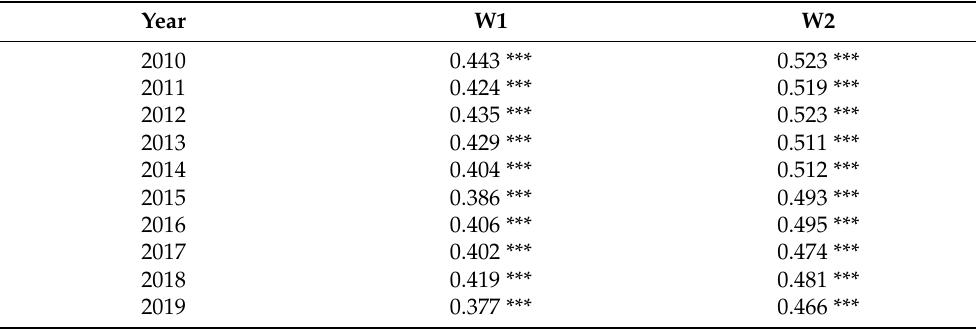
Table 6. Moran’s I for HDL with different spatial weight matrices.